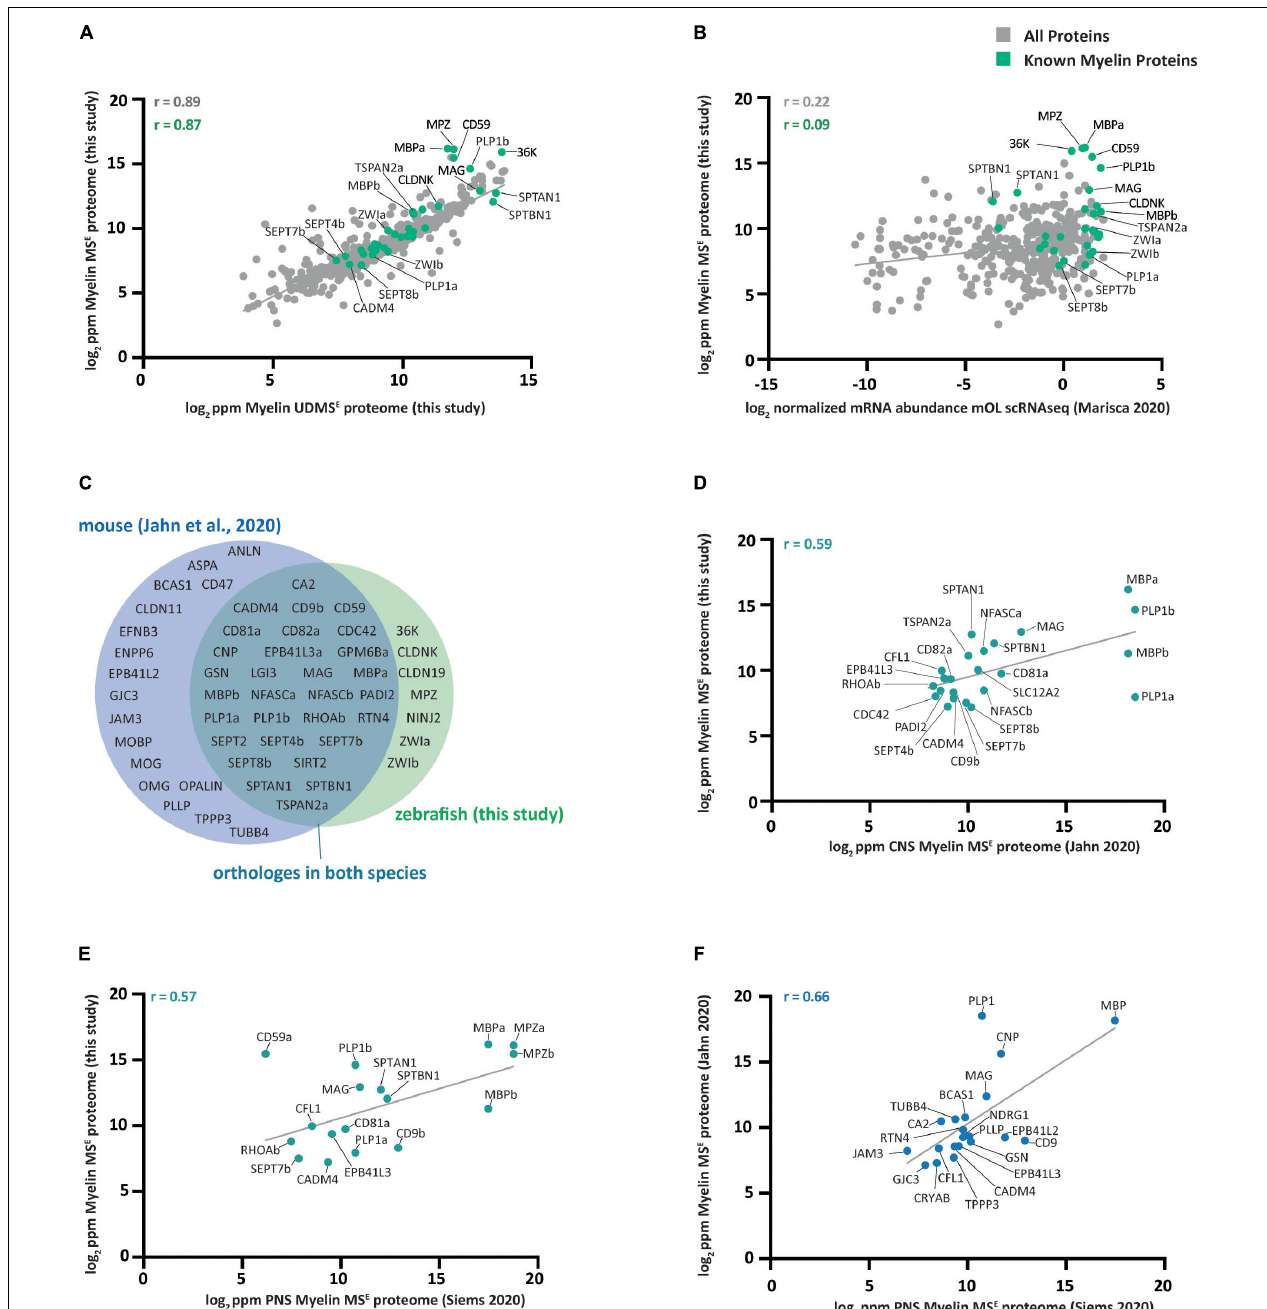
FIGURE 3 | Comparison of the zebrafish myelin proteome with other datasets. (A) Scatter plot of the log 2 -transformed relative abundance of proteins identified in this study by MS E in zebrafish CNS myelin against those identified by UDMS E . Data points representing known myelin proteins are labeled in green; other data points are in gray. The correlation coefficient was calculated for known myelin proteins (green) and for all proteins (gray) identified using both MS modes. The linear regression line is plotted for all proteins. ppm, parts per million. (B) Same as (A) but plotted against the scRNA-seq-based transcriptome of mature zebrafish oligodendrocytes (mOL) according to the normalized mean of all 19 cells in the mOL cluster according to prior assessment of oligodendrocyte lineage cells (Marisca et al., 2020). (C) Venn diagram comparing known myelin proteins identified in zebrafish CNS myelin in this study with those previously identified in CNS mouse myelin (Jahn et al., 2020). If a paralog has been reported in zebrafish, the protein name of the paralog is given. (D) Same as (A) but only known myelin proteins identified by MS E in zebrafish myelin are plotted against the CNS myelin proteome of c57Bl/6N mice as previously assessed by the same mode (Jahn et al., 2020). Only proteins present in both datasets are plotted. (E) Same as (D) but known myelin proteins identified by MS E in zebrafish CNS myelin are plotted against the mouse PNS myelin proteome as previously assessed by the same mode (Siems et al., 2020). (F) Same as (D) but known myelin proteins identified by MS E in mouse CNS myelin mode (Jahn et al., 2020) are plotted against those identified by MS E in mouse PNS myelin (Siems et al., 2020).